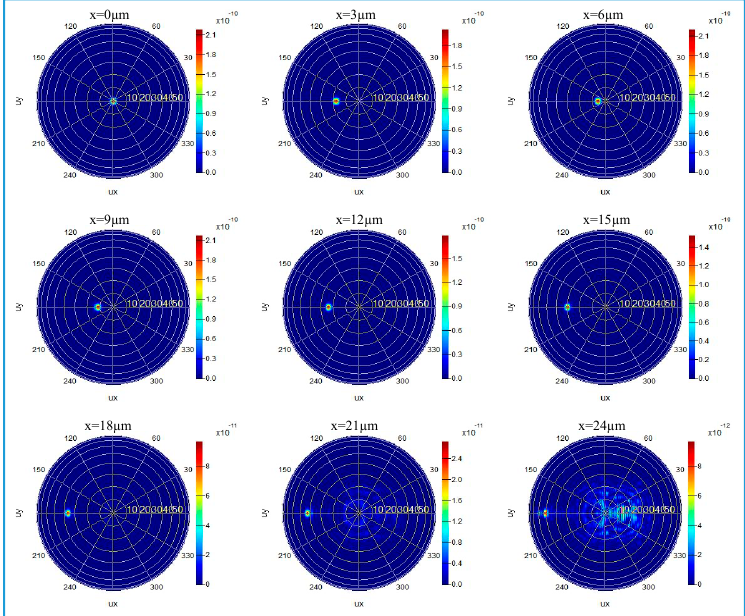
Figure A4. Intensity distribution of the reflected light in the coordinate system of inclination angle and azimuth angle. The Gaussian source is localized on the focal plane with coordinates (0–24 µm, 0, 30 µm), which is reflected by the meta-reflector with DBR in Figure 4a.